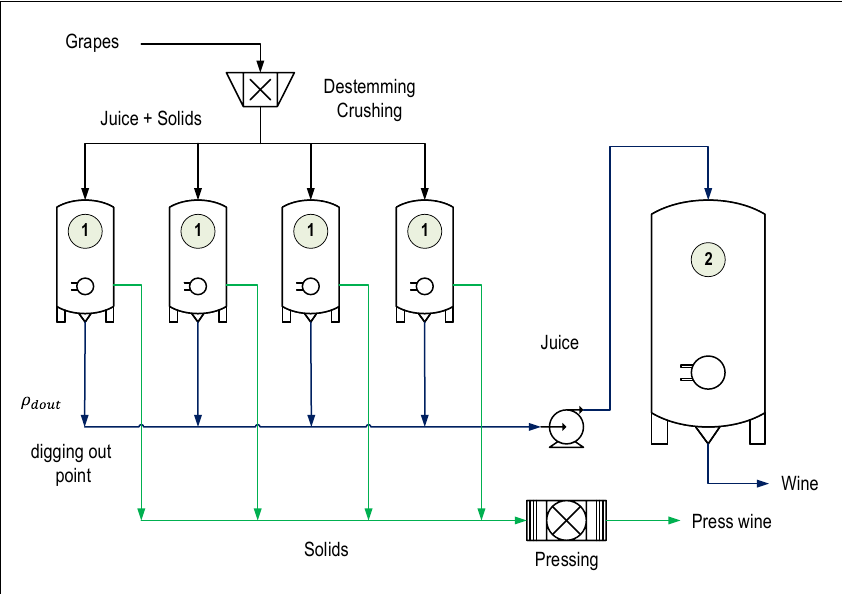
Figure 1. Scheme for industrial bulk red winemaking: fermentative maceration (1) and alcoholic fermentation completion (2). The blue line represents the juice fed at the digging-out point to complete the alcoholic fermentation, and the green line represents the solids (pomace) fed to produce press